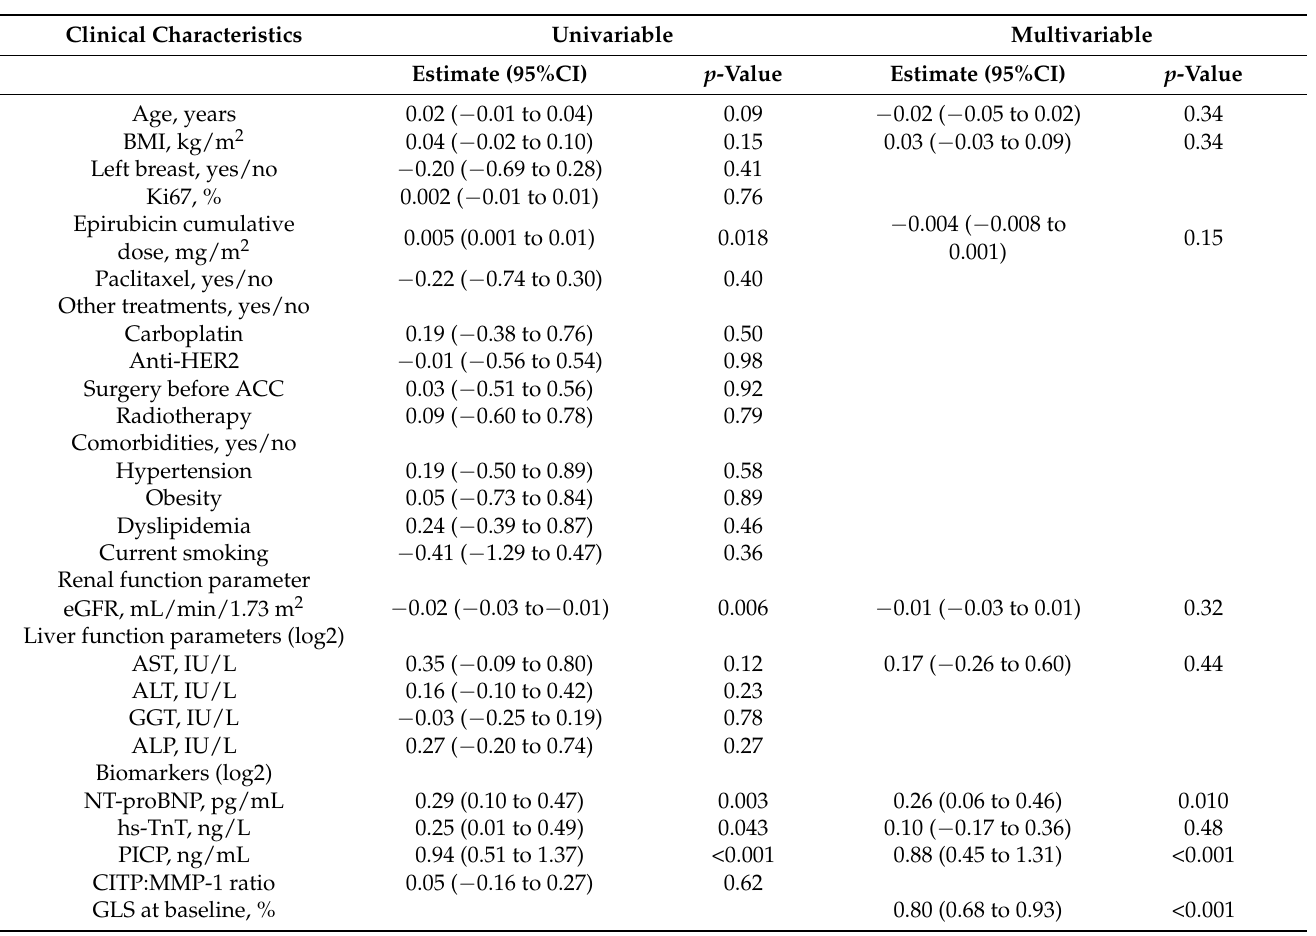
Table 2. Linear mixed regression analyses for the association with global longitudinal strain in BC patients 3 months after completion of ACC therapy (CUN